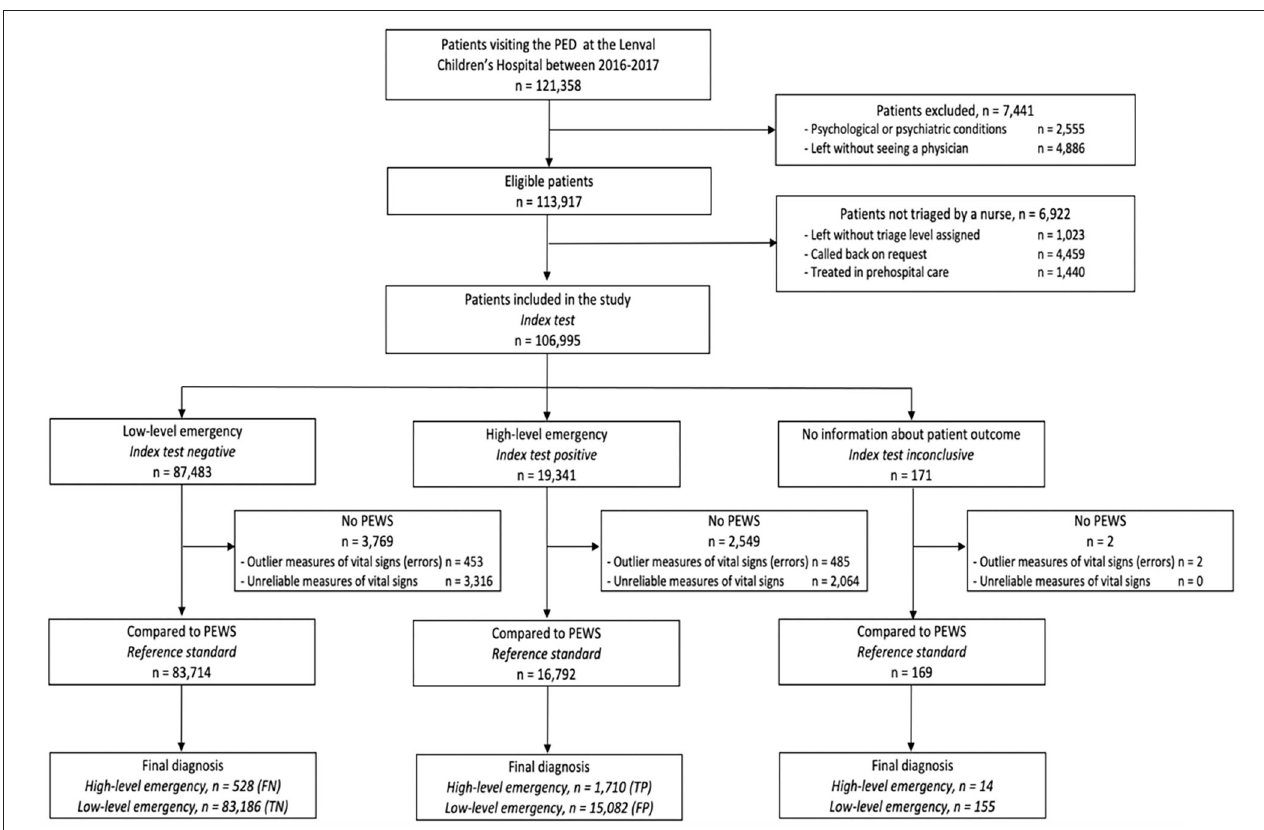
FIGURE 1 | STARD flow diagram presenting patients triaged by both pediaTRI (index test) and PEWS (reference standard). TP, true positive; TN, true negative; FP, false positive; FN, false negative.